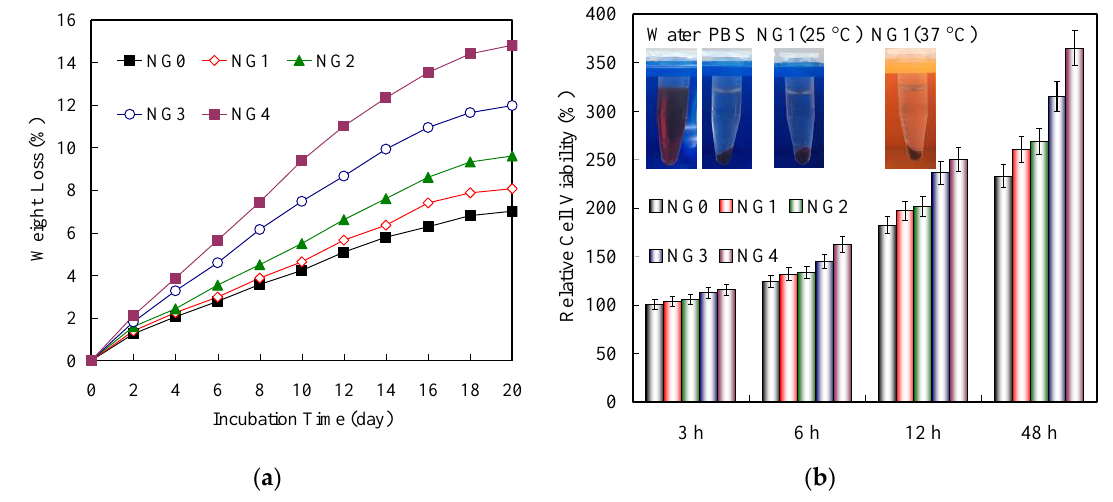
Figure 6. ( a ) Stability in the PBS solution and ( b ) biocompatibility of NG0, NG1, NG2, NG3, and NG4. The inset shows a photograph of HRBCs exposed to water, PBS, NG1 at 37, 25 ◦ C, respectively, followed by